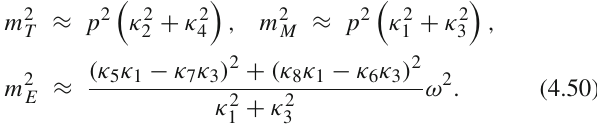
The corresponding elements are given